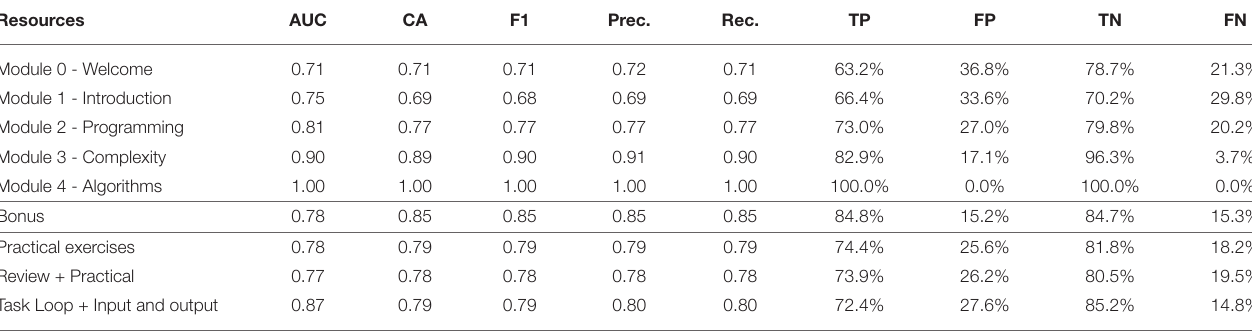
TABLE 1 | Neural network metrics for the prediction of course completion. Resources AUC CA F1 Prec. Rec.